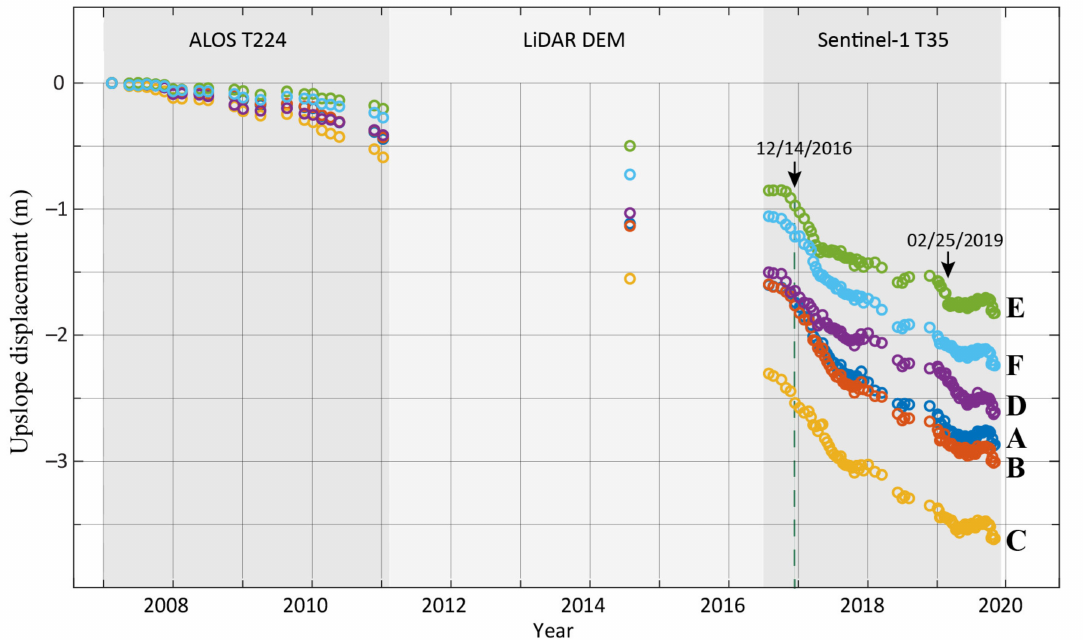
Figure 8. Long-term deformation of the Hooskanaden landslide from 2007 to 2019. Cumulative along-slope displacements of multiple points (cyan dots in Figure 7) of the Hooskanaden landslide